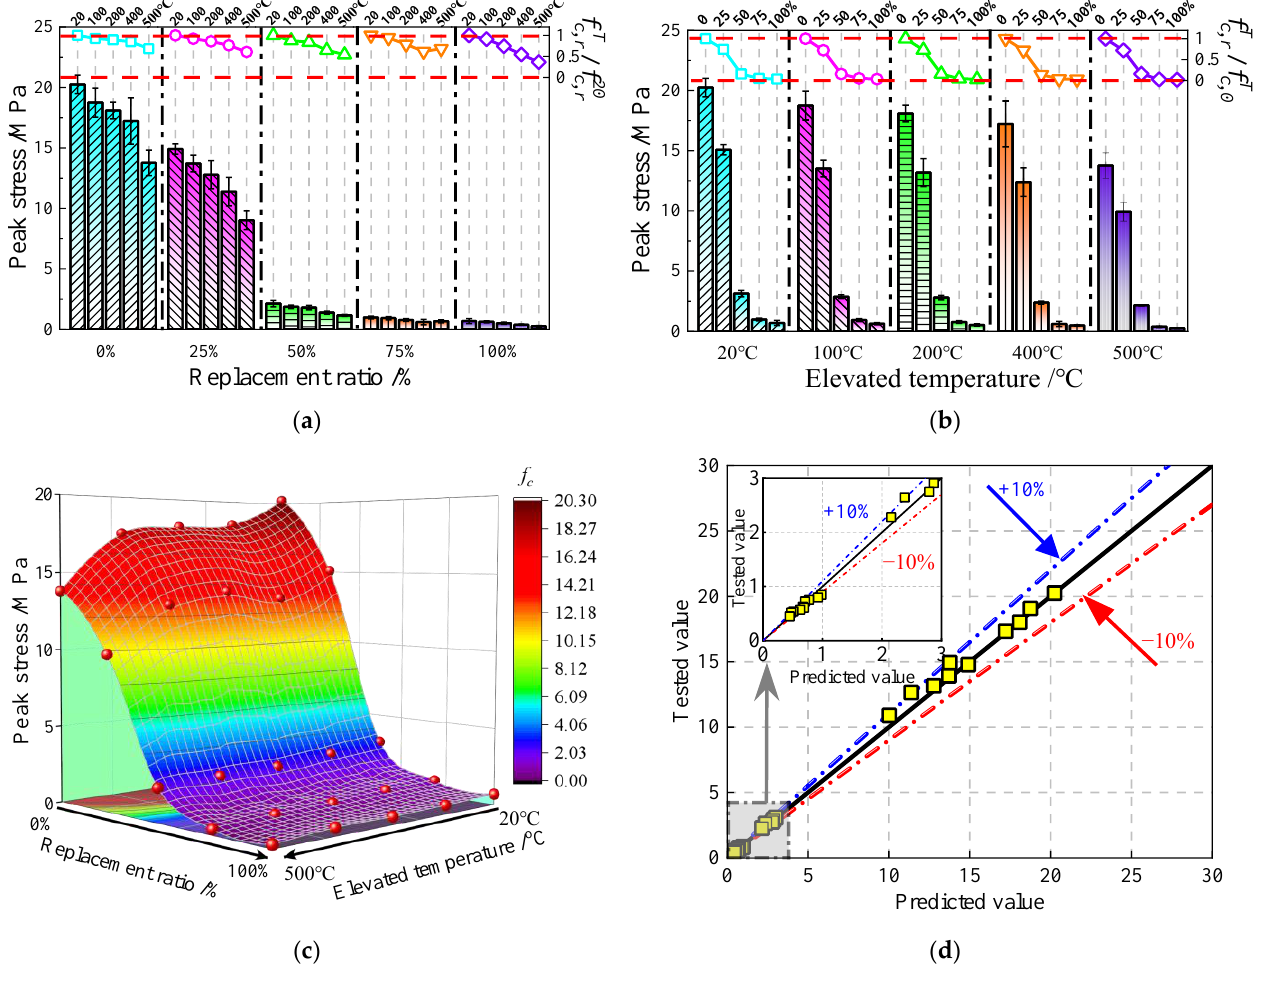
Figure 10. Peak stress of JNC. ( a ) Effect elevated temperature on f c . ( b ) Effect of replacement ratio on f c . ( c ) Surface of f c under the effect of replacement ratios and elevated temperatures. ( d ) Comparison of tested values and predicted values.